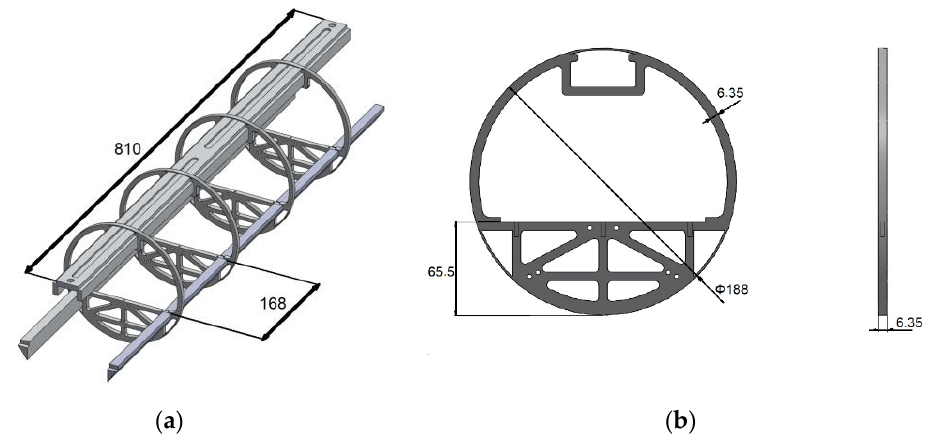
Figure 10. Schematic view of the internal structure of the autonomous underwater vehicle (AUV) and its sliding stiffeners: ( a ) overall structural arrangement; ( b ) ring stiffener detail.